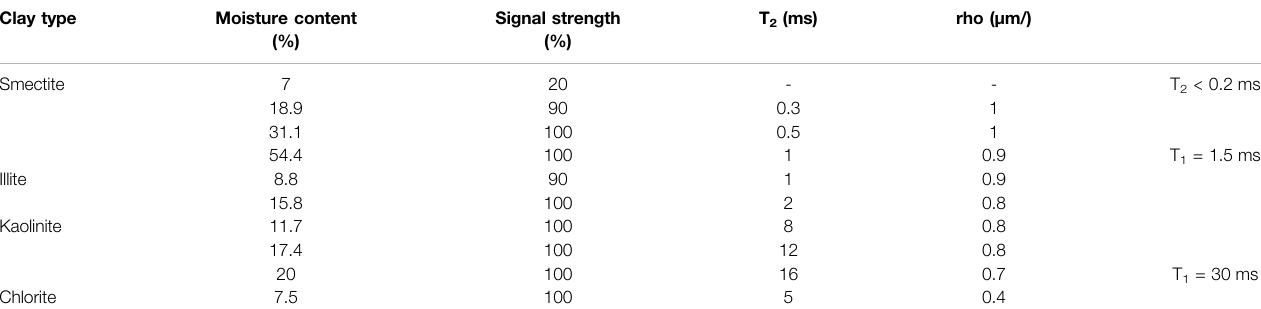
TABLE 1 | Relaxation times of different clay types.